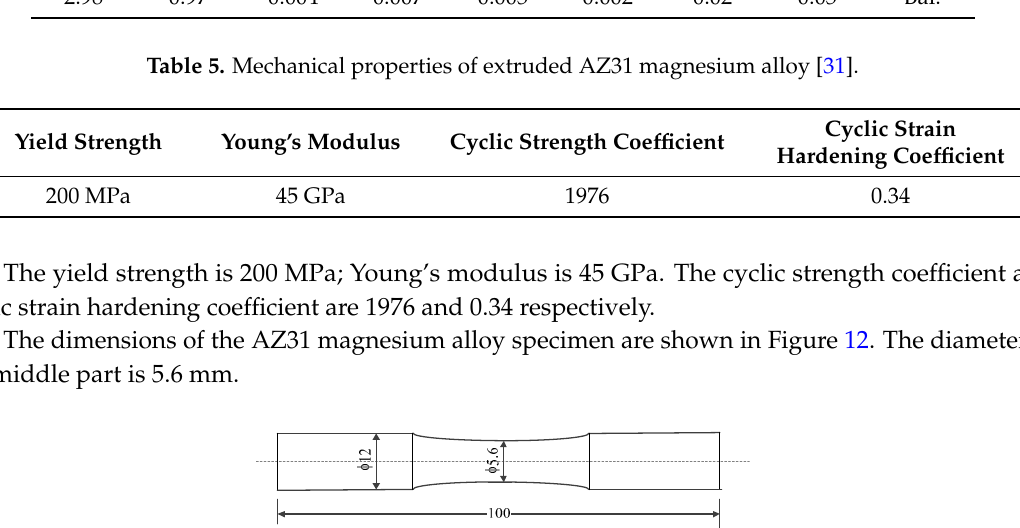
Figure 14. Predicted fatigue life of AZ31 magnesium alloy.